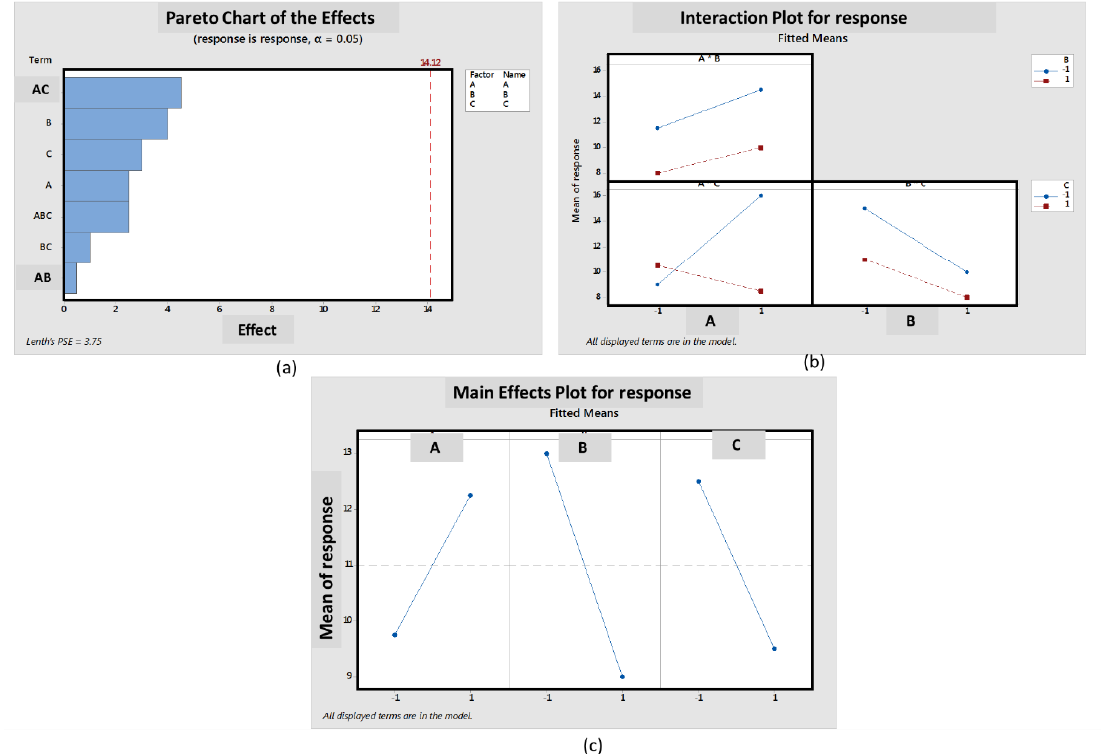
Figure A16. Analysis of the factorial design tests: ( a ) Pareto chart of the effect; ( b ) Interaction plot for response; and ( c ) main effects plot for response. It can be seen that high power and high scan speed is detrimental for PBF processing. (A = laser power, B = scan speed, C = substrate thickness).